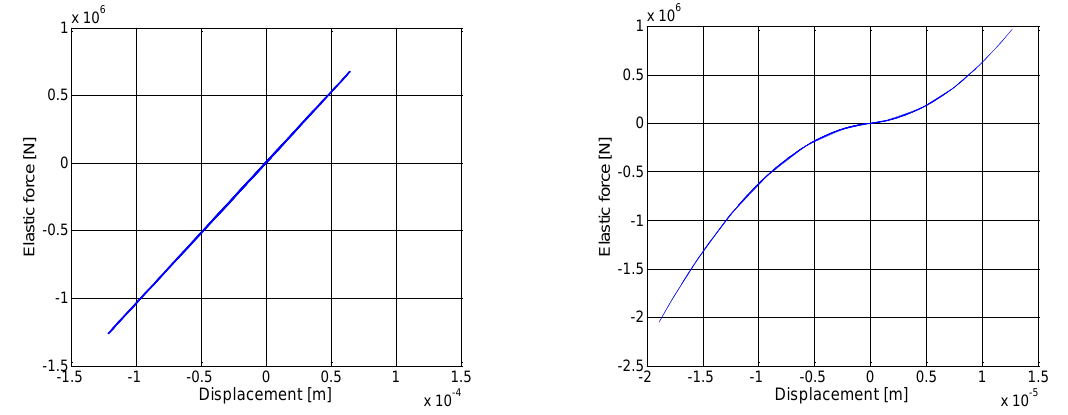
Fig. 7. The representations of stiffness coefficients: Linear case. Fig. 8. The representations of stiffness coefficients: Nonlinear case.